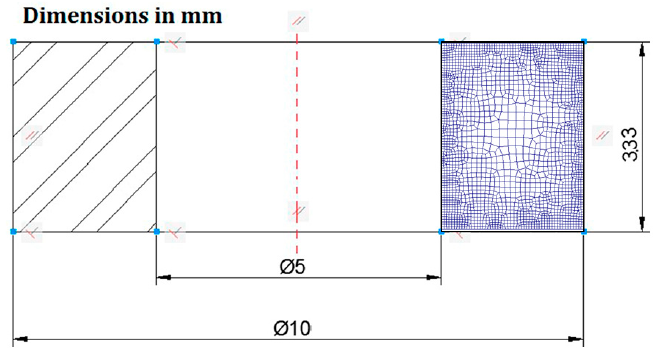
Figure 3. Geometry of the rings tested by RCT.